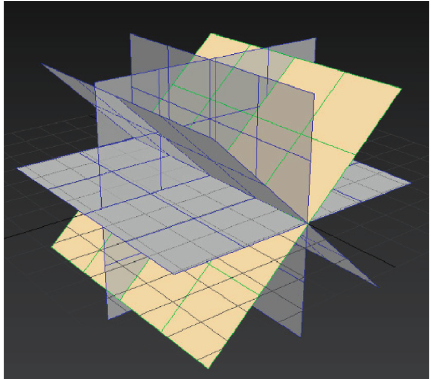
Figure 7: The insertion of five planes.